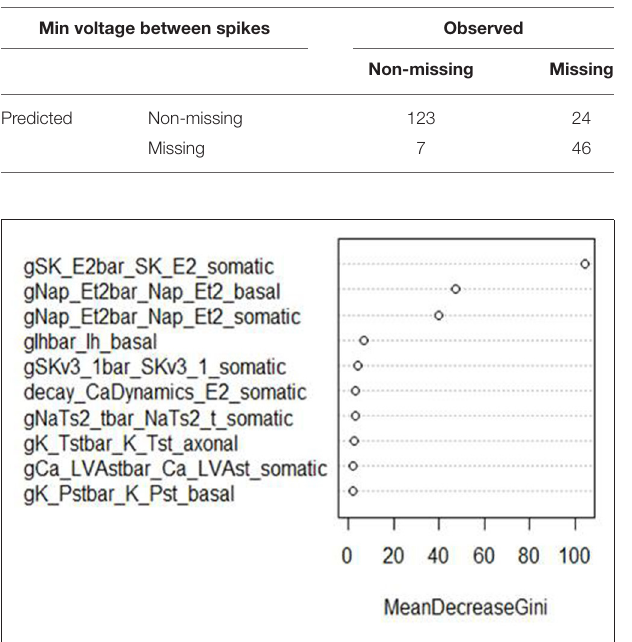
FIGURE 6 | Variable importance plot for the RF classifier of AP amplitude, using the data from generation 6.